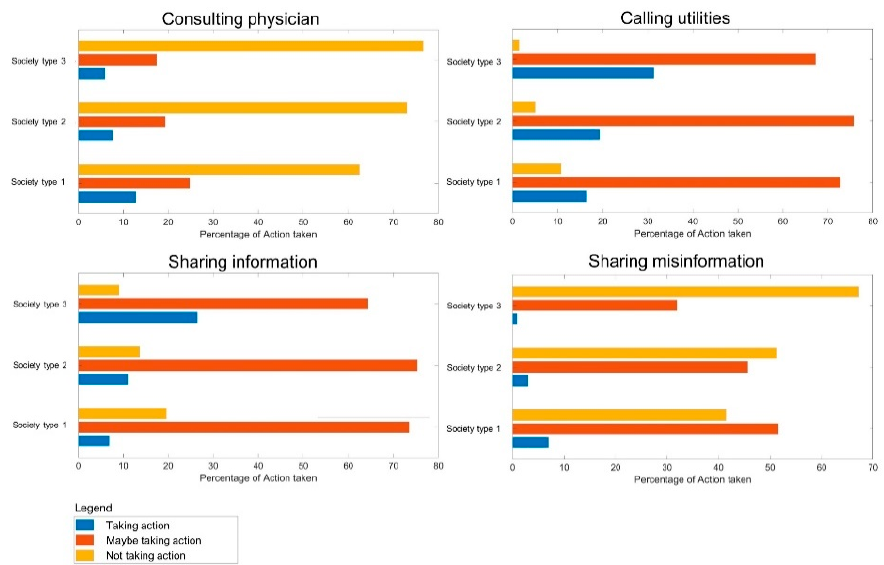
Figure 11. Scatter plot of the fuzzy logic system output in scenario three for the three different society types and the four different possibly taken actions.